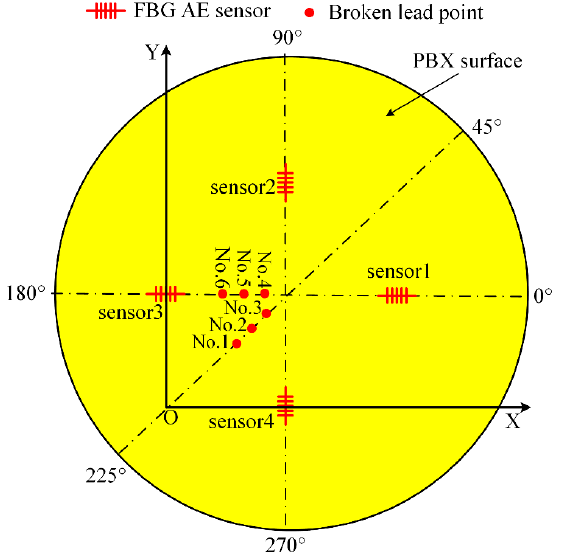
Figure 12. Locations of the broken lead.